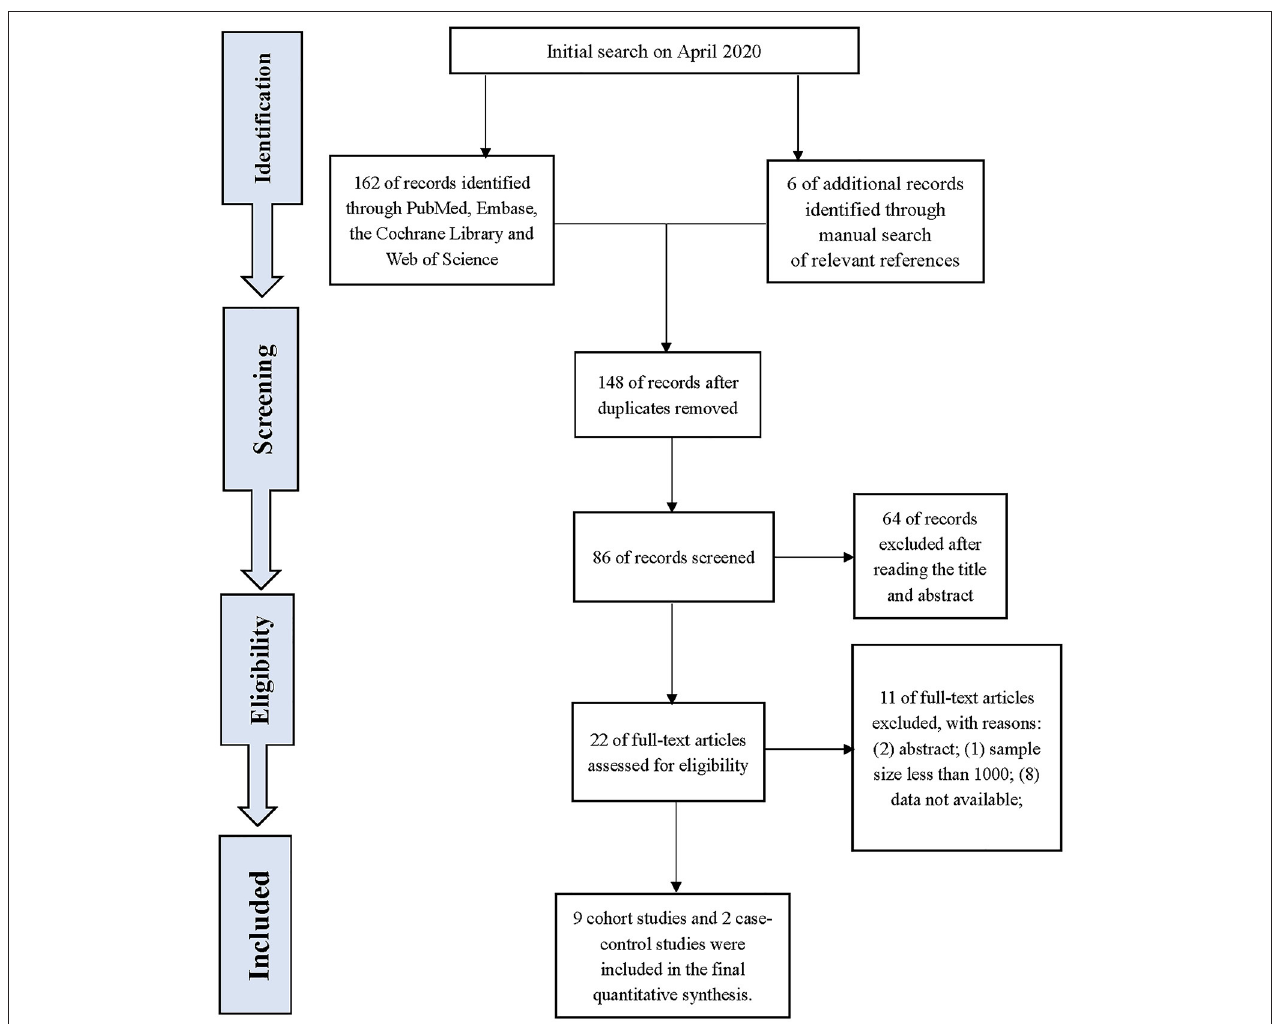
FIGURE 1 | Flow diagram of searching, inclusion, and exclusion of relevant studies.